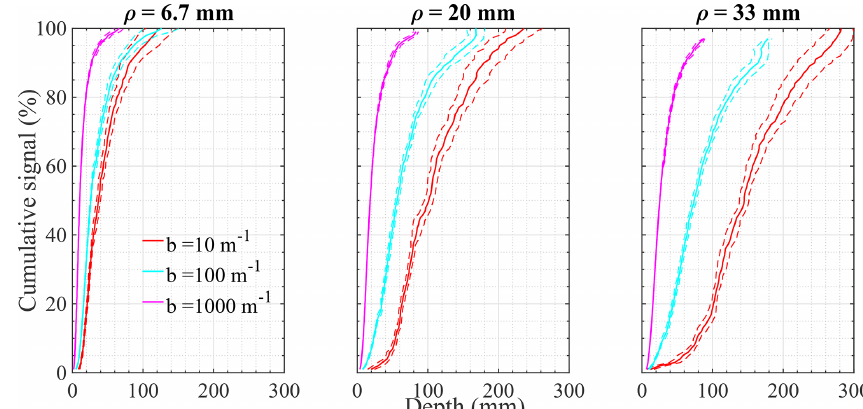
Figure 6. Estimation of the depth of signal origin for our probe geometry simulated by Monte Carlo. The cumulative signal R(zr)/R z max (r) vs. absorptive plate depth z at different lateral distances ρ was evaluated for three b values typical of sea ice, a = 0 . 1m − 1 and g = 0 . 94. We ran 40 simulations of 10 6 photons for every z when b = 10 and 100m − 1 and 10 simulations of 10 6 photons for every z when b = 1000m − 1 . The standard deviation on simulations was used to evaluate uncertainties.